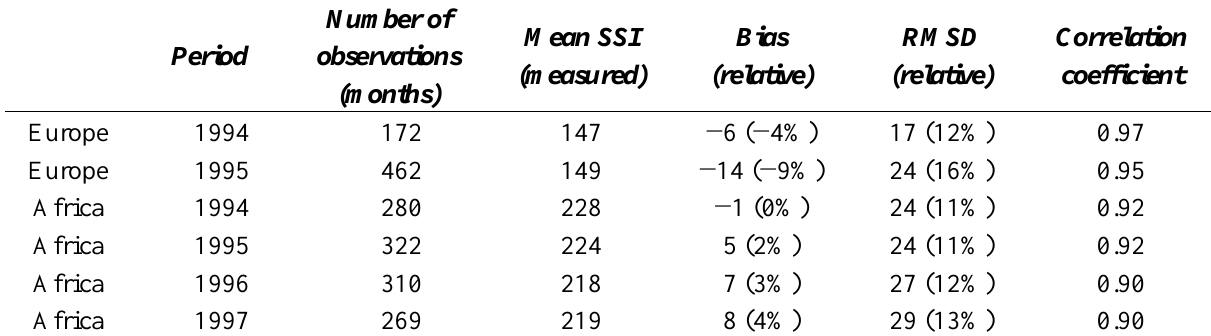
Table 2. Comparison between HC-1 and ground-based measurements of monthly mean